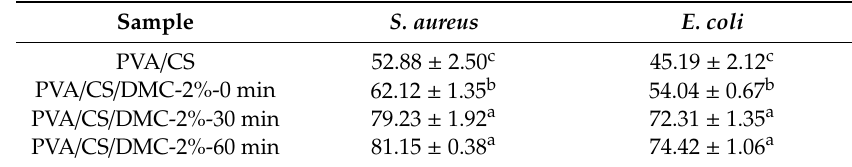
Table 4. Antimicrobial e ff ect of the typical PVA / CS / DMC composite films with a concentration of 2% under di ff erent ultrasound times against Escherichia coli , Staphylococcus aureus